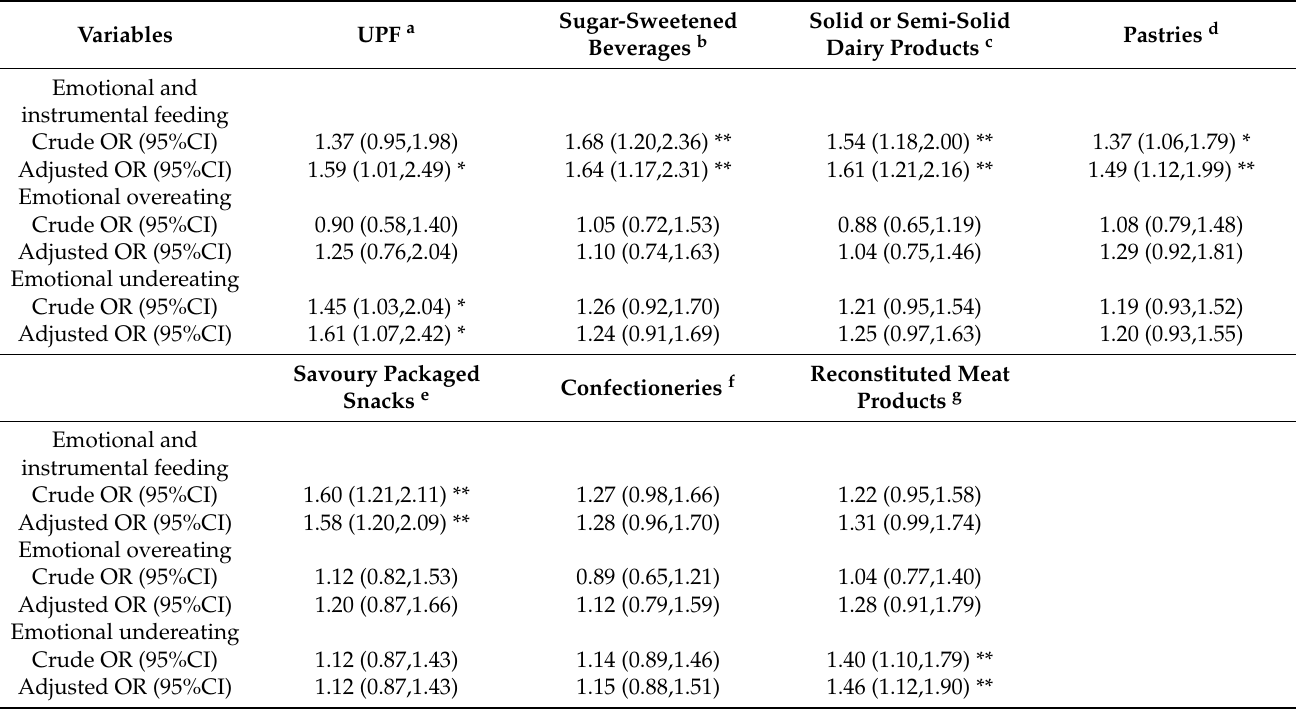
Table 3. The associations between children’s UPF consumption and caregivers’ emotional and instrumental feeding, as well as children’s emotional eating ( n = 408).